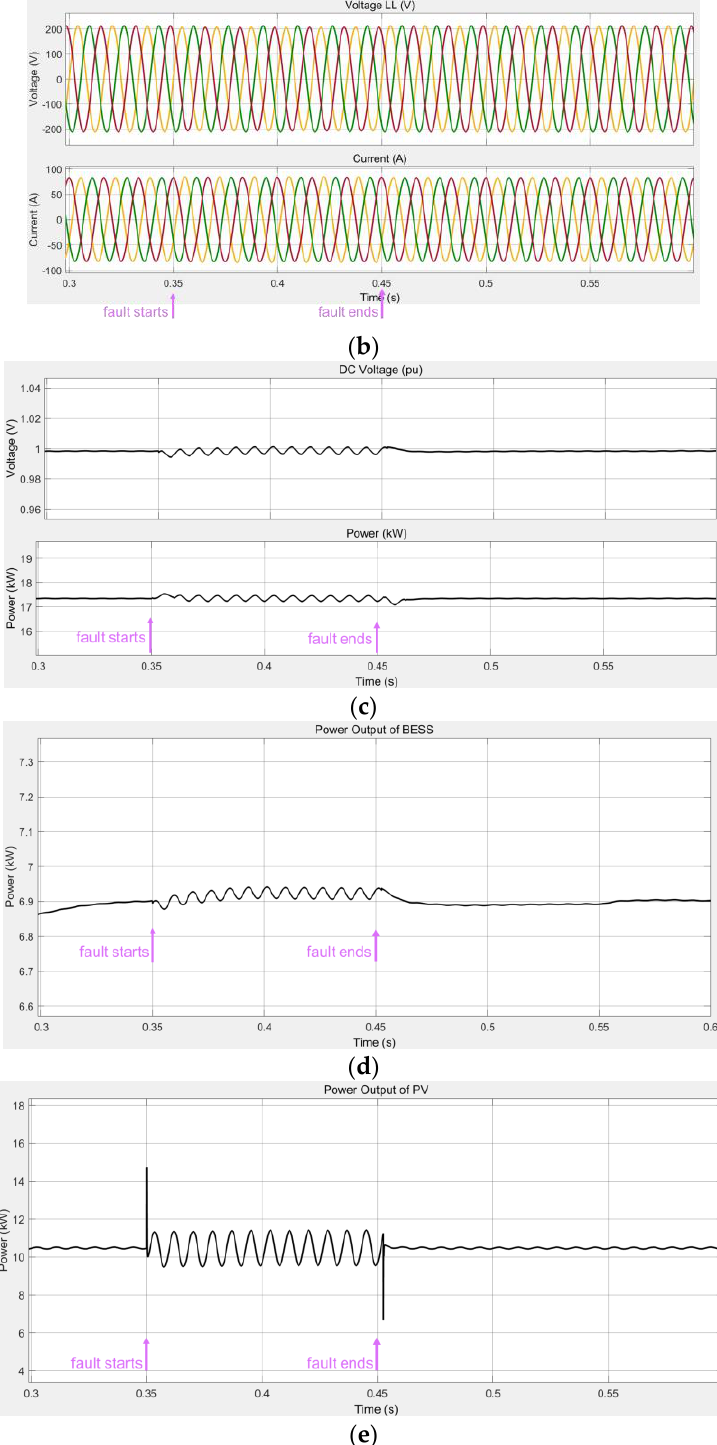
Figure 9. Performance when a single phase-to-ground fault occurs on the AC side. ( a ) Signals at Bus 6; ( b ) Signals at AC/DC interfacing Bus 8; ( c ) Signals at DC bus; ( d ) Power output of the BESS; ( e ) Power output of the PV generation.